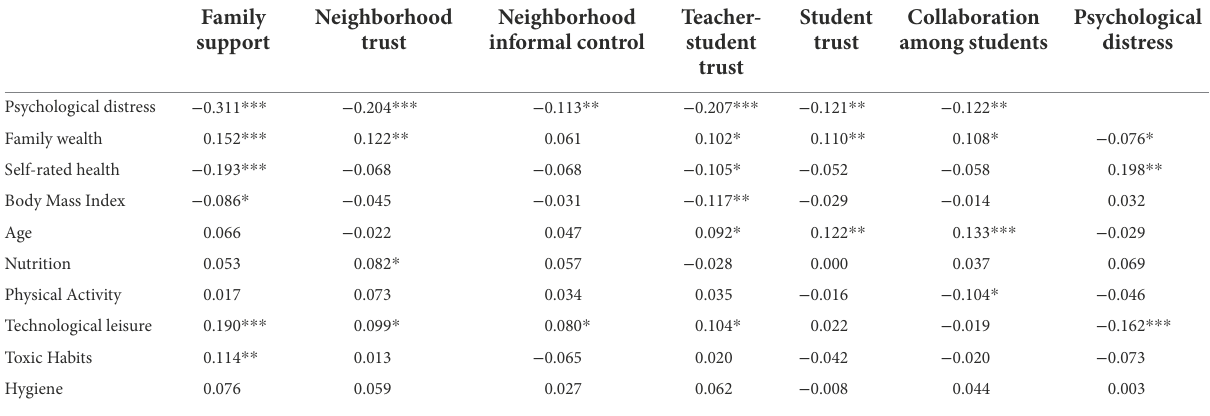
TABLE 3 Results of the correlational analysis.